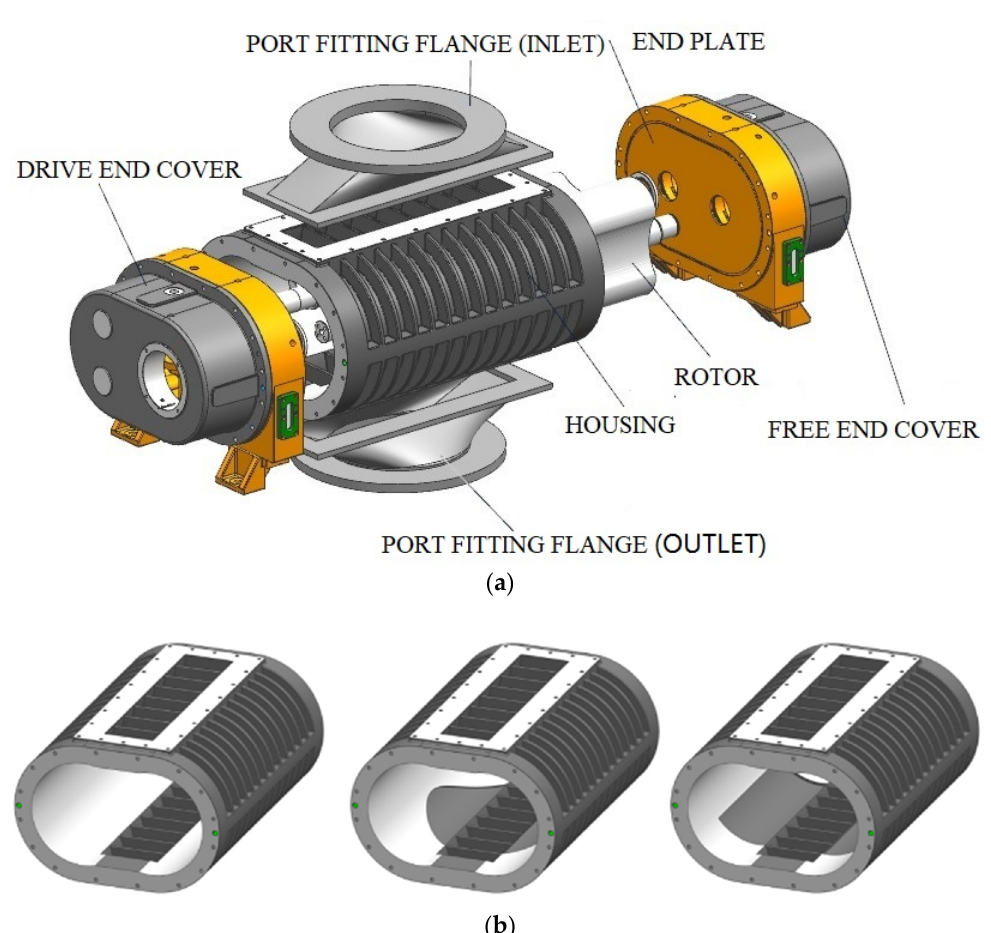
Figure 1. Three-dimensional model of the Roots pump: ( a ) overall model; ( b ) model of the housing.